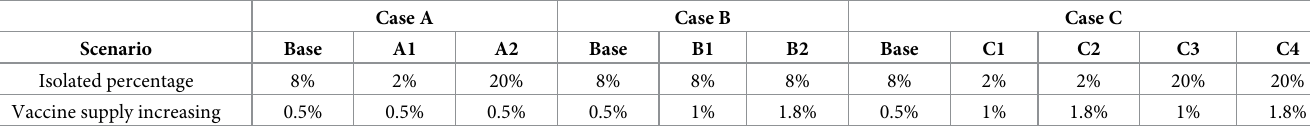
Table 3. Scenario settings under different isolated percentage and vaccine supply increasing.